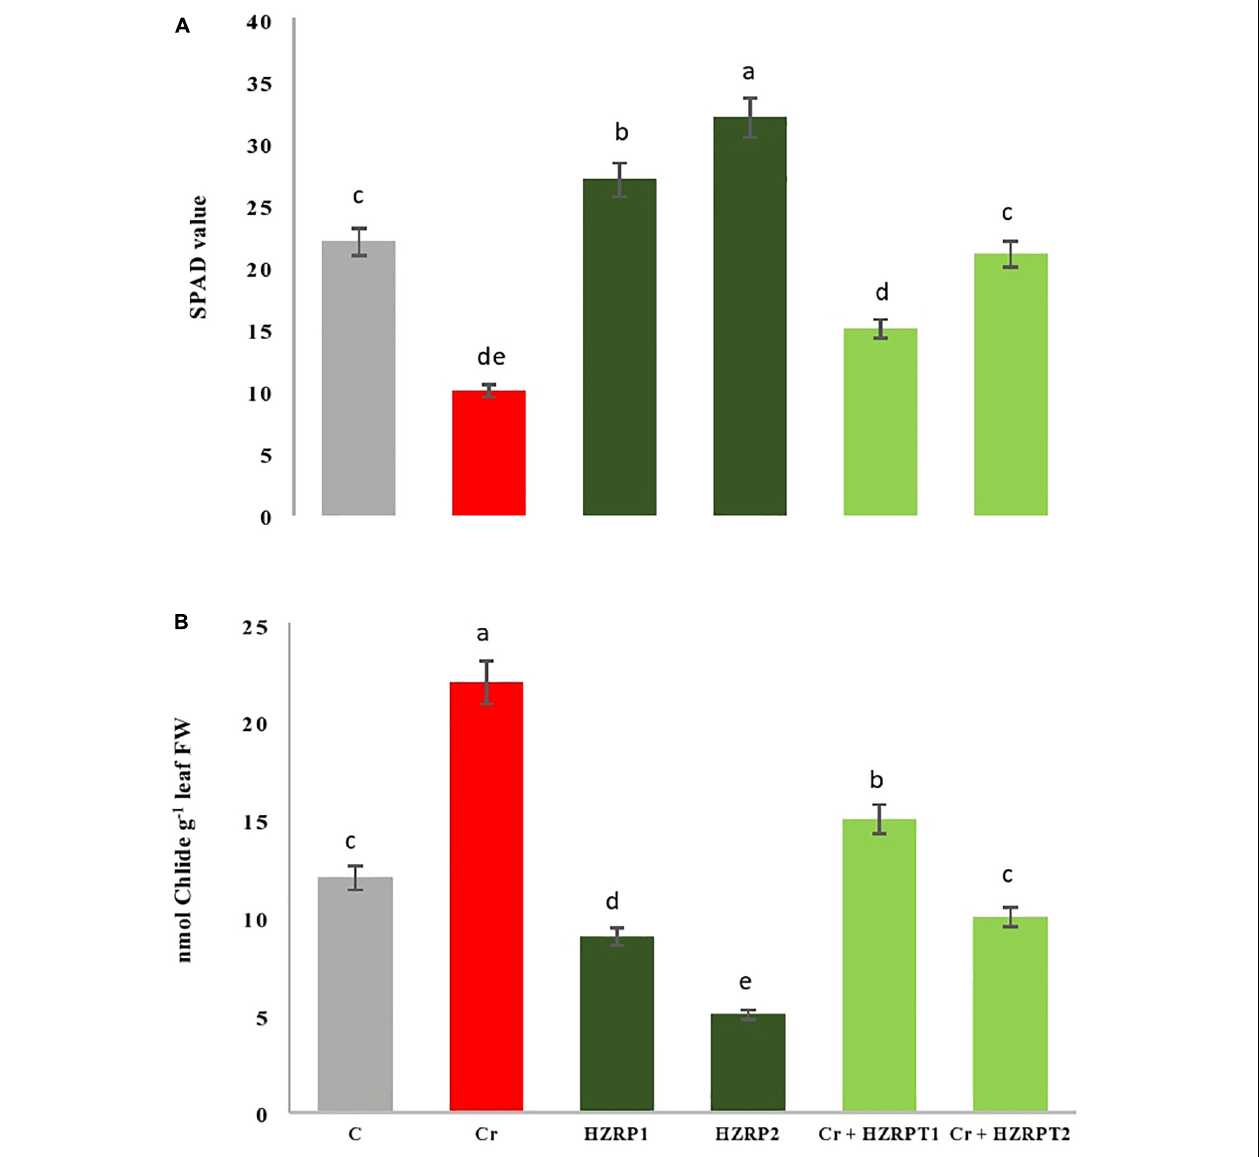
FIGURE 5 | Effect of harzianopyridone on Ch1 content (A) and chlorophyllase activity (B) in Vigna radiata seedlings grown in Cr toxificated soil. Different letters indicate significant difference among the treatments ( p < 0.05). Cr, 50 mg kg − 1 , HZRP1, 1 p.p.m; HZRP2, 2 p.p.m.